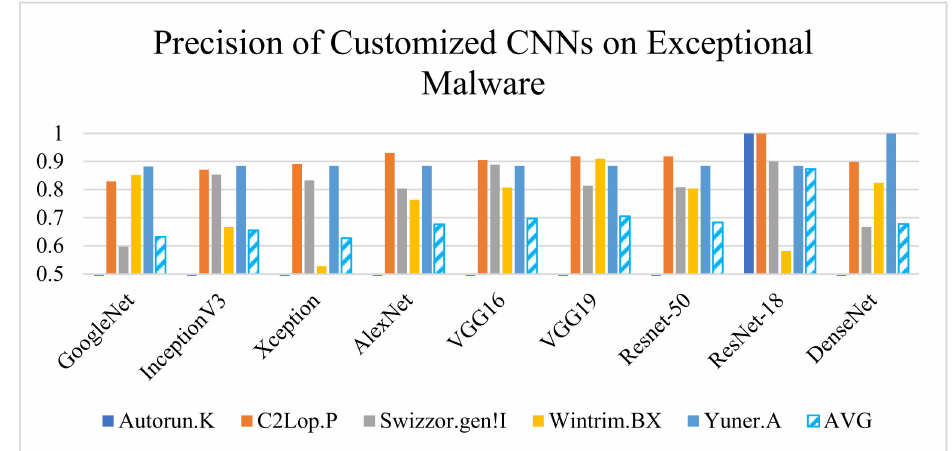
Figure 8. Performance (precision) comparison of implemented CNN models.